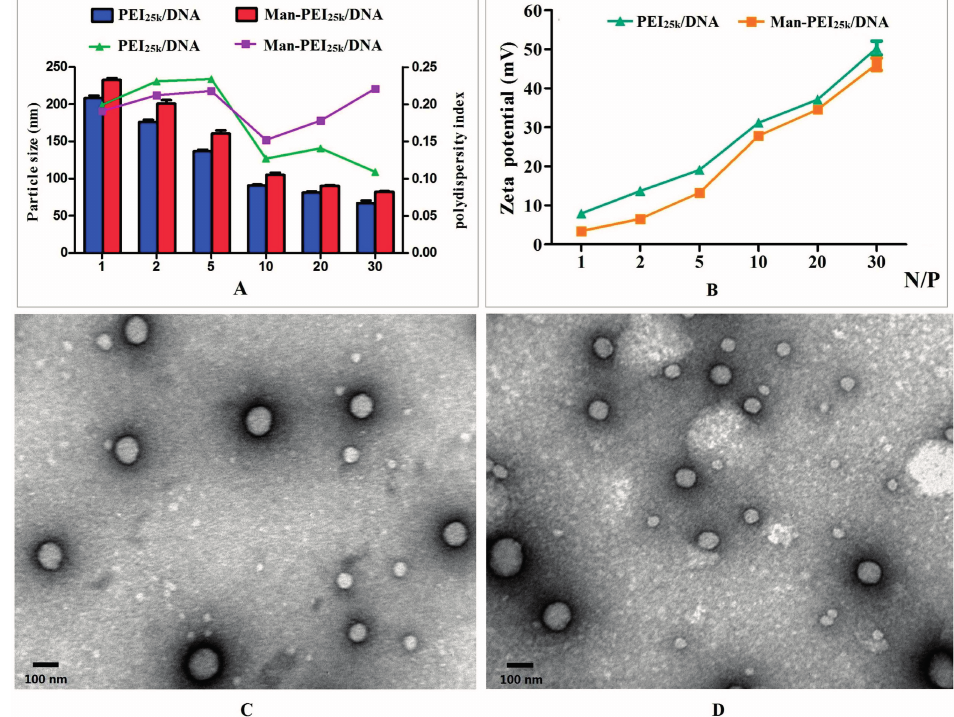
Figure 3. Characterization of the PEI/DNA complexes. ( A ) Nanoparticle size and polydispersity index of the two complexes formulations; ( B ) Zeta potentials of the two complex formulations at various N/P ratios; ( C ) TEM images of Man-PEI 25k /DNA complexes at an N/P charge ratio of 10; and ( D ) TEM images of the PEI 25k /DNA complexes at an N/P charge ratio of 10. Notes: Each data point represents the mean ± standard deviation ( n = 3).